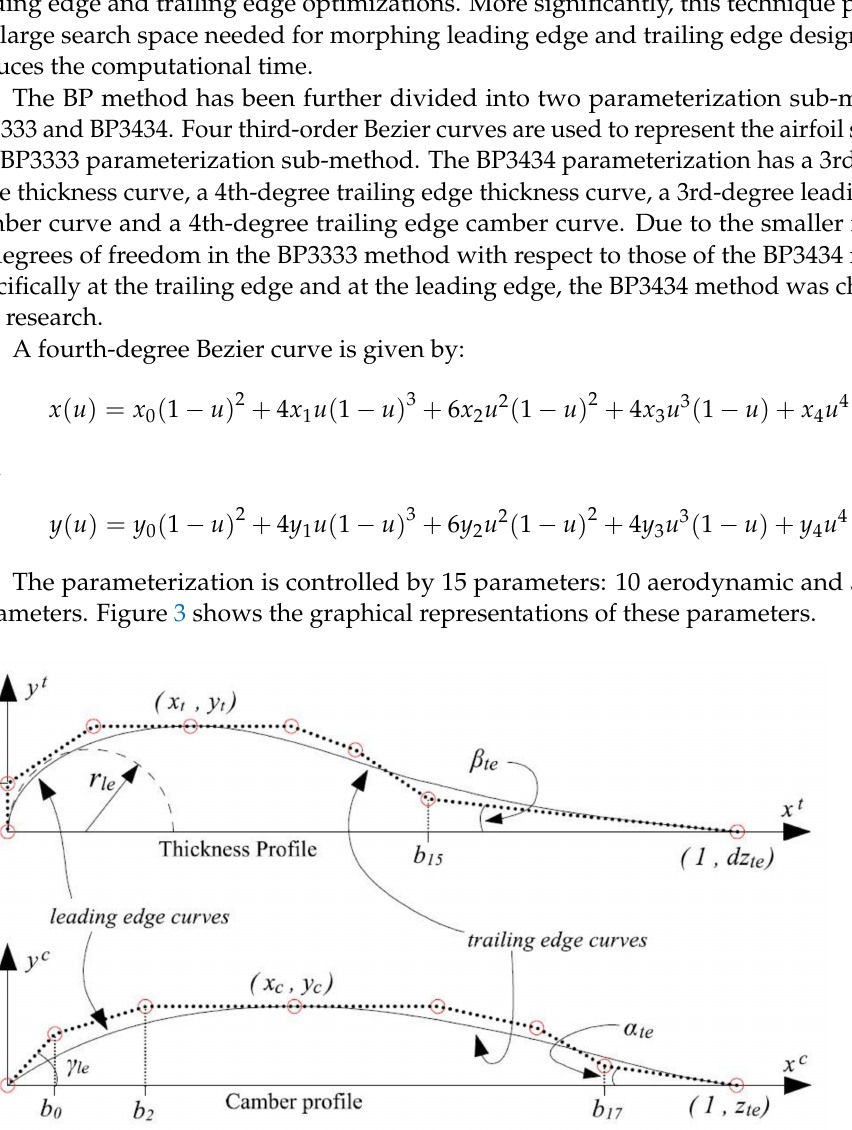
Figure 3. BP3434 method parameter definition. The BP3434 parameterization has a 3rd-degree edge thickness curve, a 4th-degree trailing edge thickness curve, a 3rd-degree leading edge camber curve and a 4th-degree trailing edge camber